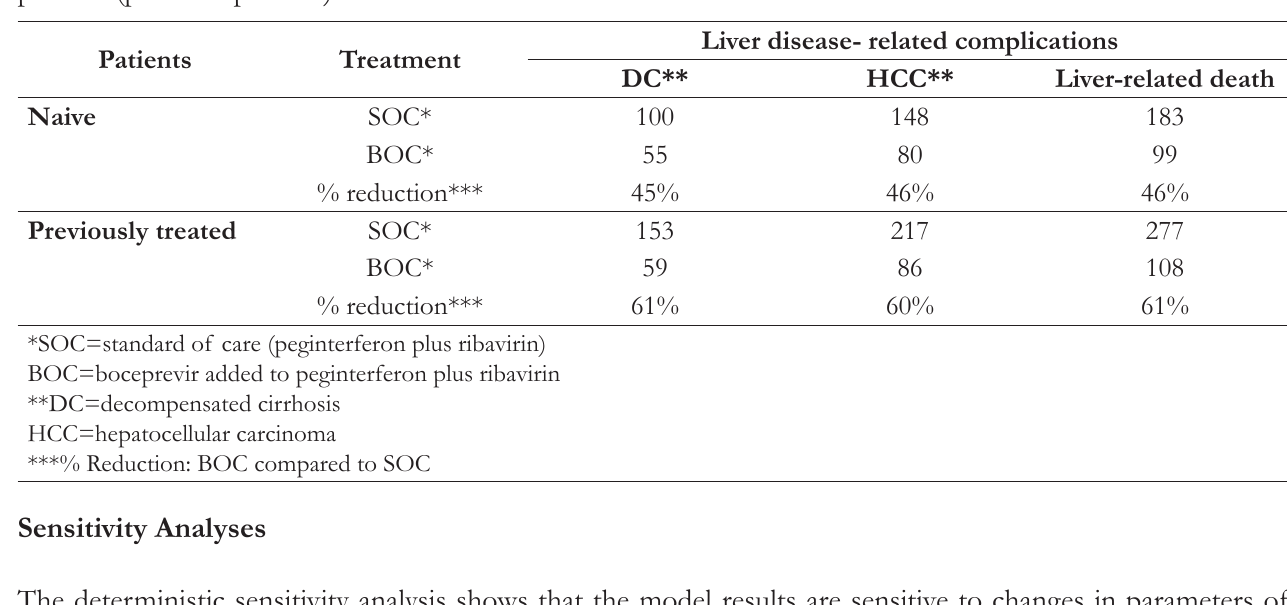
Table 8. Projected lifetime incidence of serious liver complications in the treatment naïve and prevously treated patients (per 1000